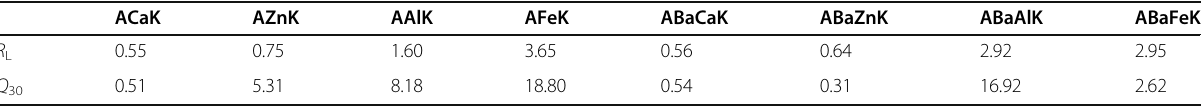
Table 5 Rate and onset quantity results obtained for alginate metal complexes beads